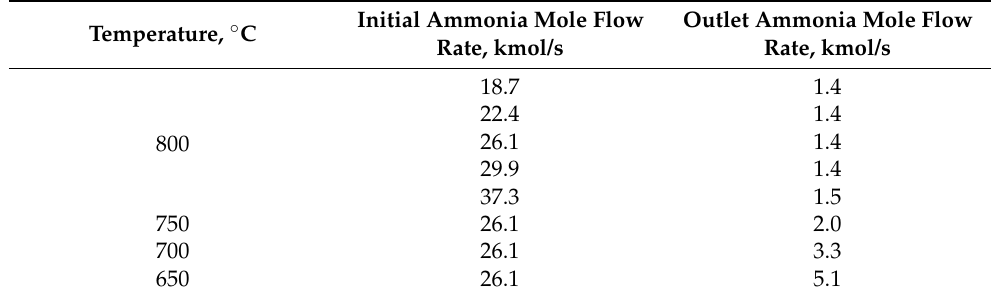
Table 1. Dependence of the ammonia flow rate at the outlet of the reactor on its flow rate at the inlet and the temperature in the